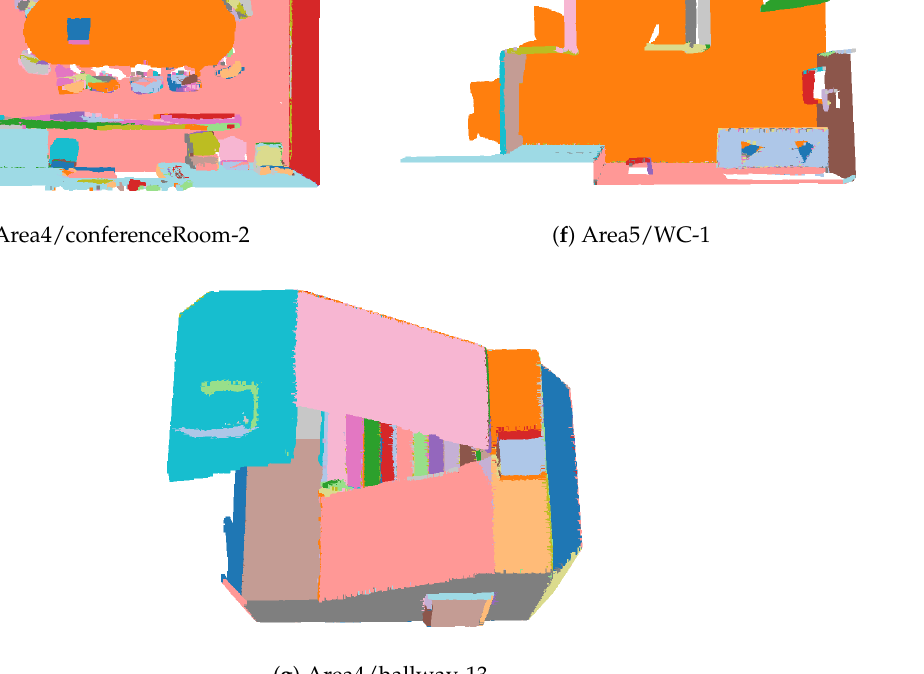
Figure 8. Preview of the results of the proposed method for seven exemplary validation